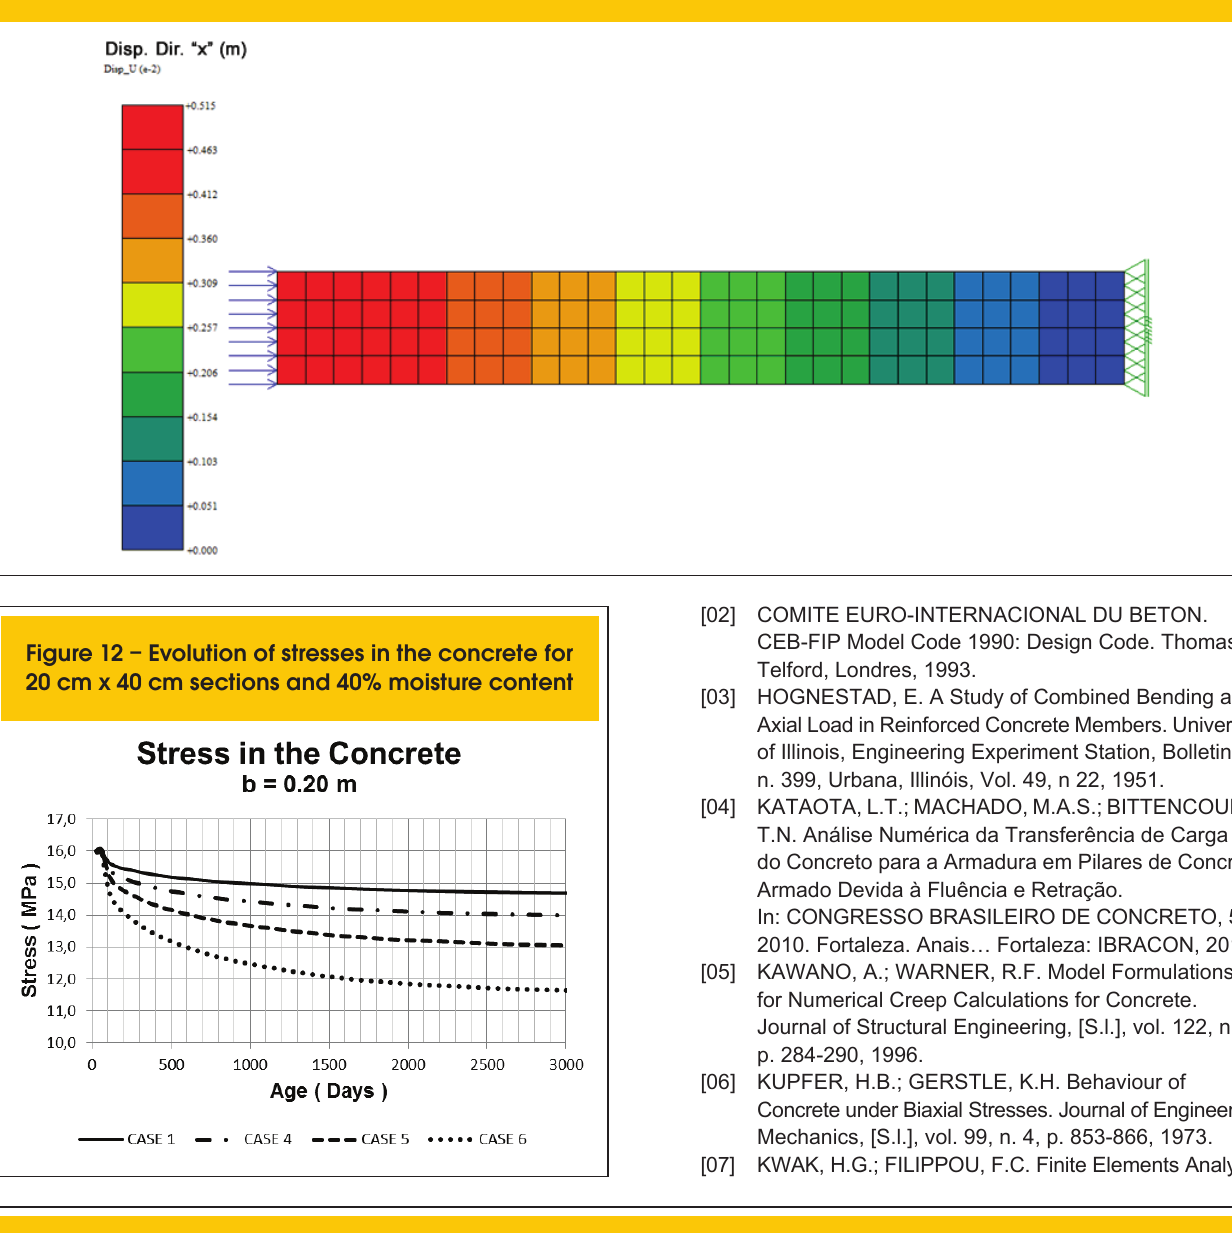
Figure 11 – Longitudinal displacement field due to creep at 3000 days - Case 19